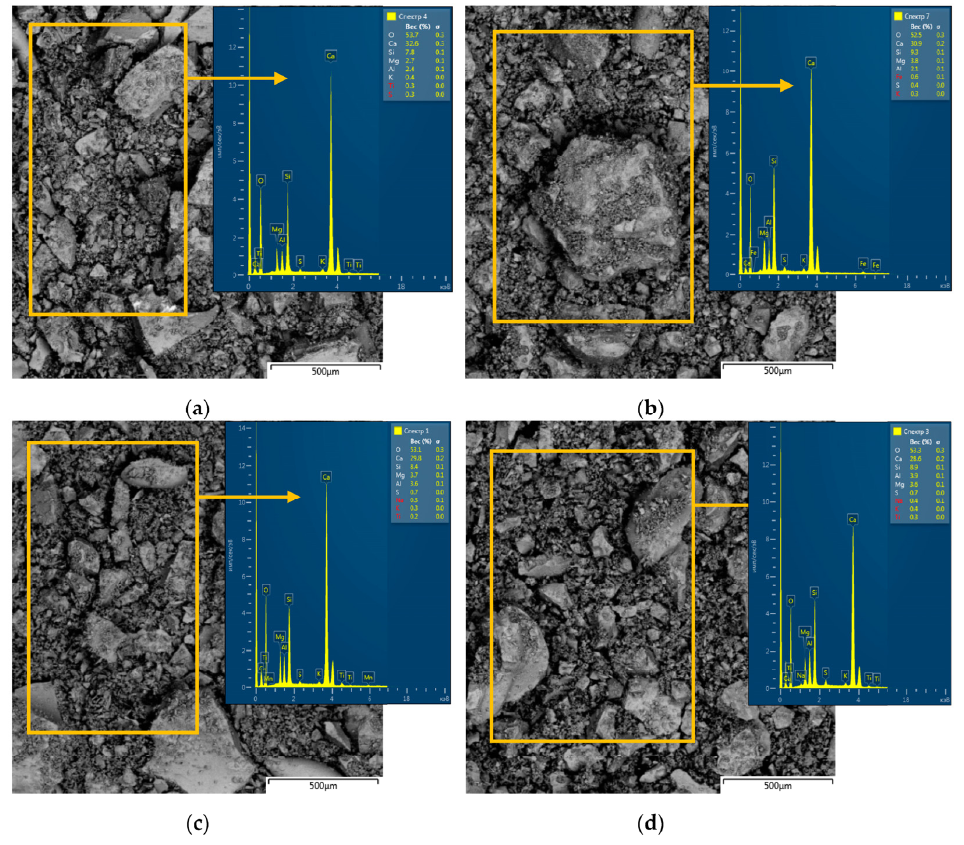
Figure 1. SEM and EDX (a separate samples from a group of averaged) images of metallurgical slags of various origins: ( a ) PAO «Severstal», ( b ) PAO «NLMK», ( c ) PAO «Mechel» and ( d ) JSC «ArcelorMittal Temirtau».